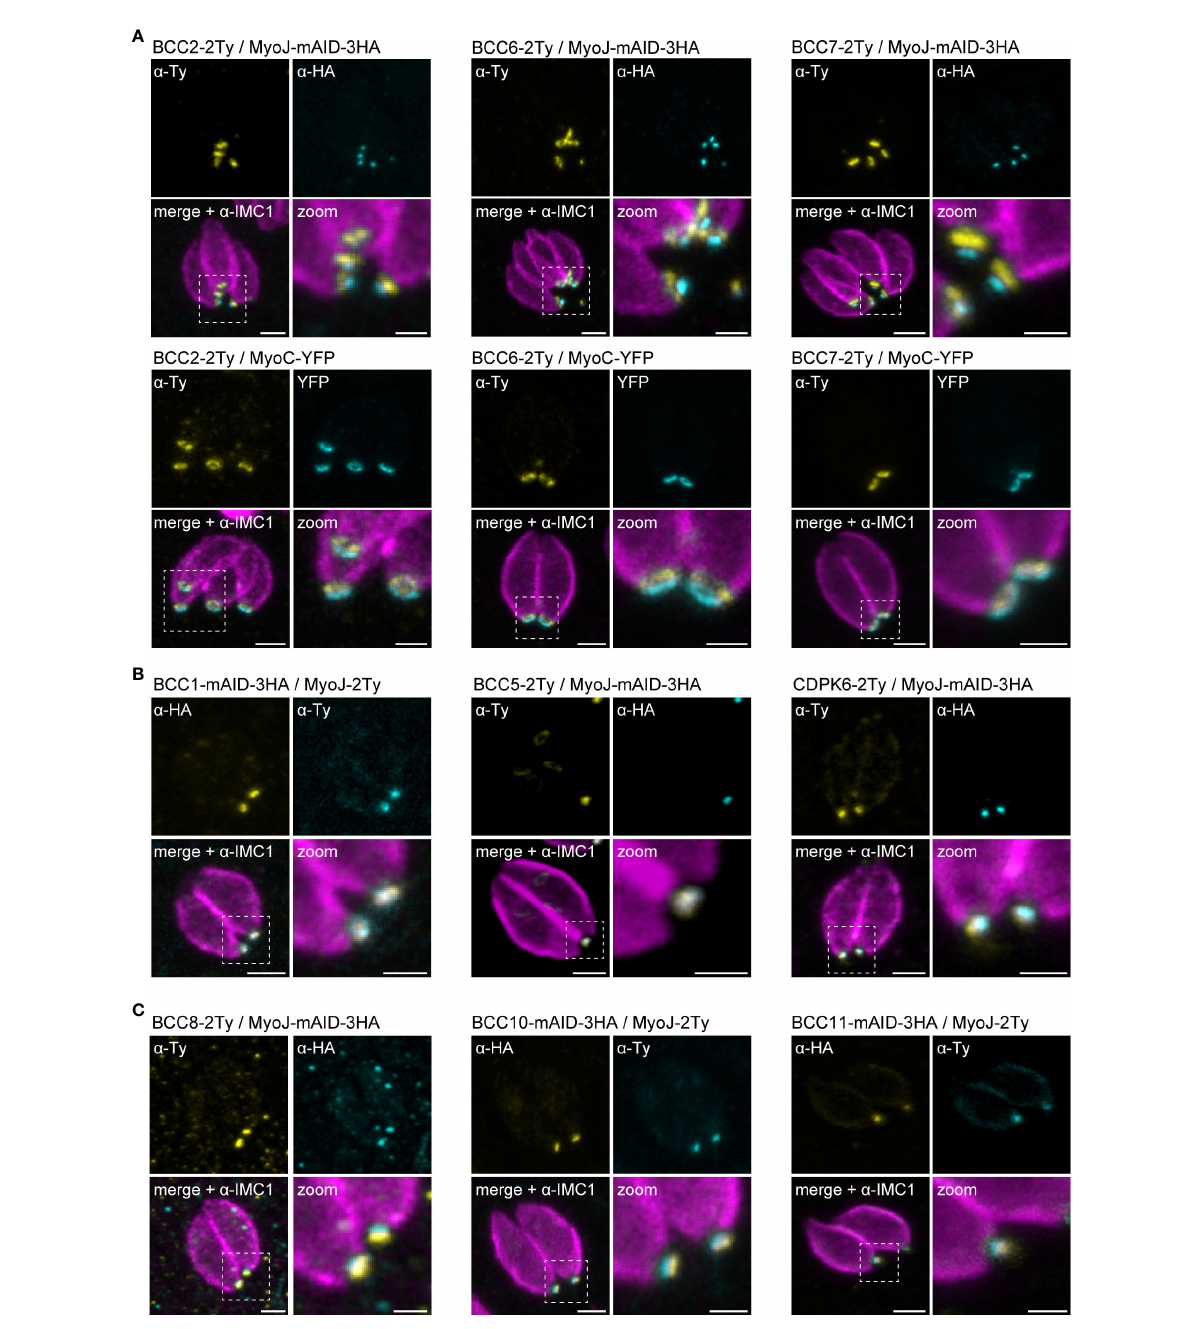
FIGURE 4 Mapping of the BCCs in three sub-compartments of the basal complex, including two new ones. (A) Co-localization of BCC2, BCC6, and BCC7 with endogenously tagged MyoJ and MyoC showing that these three proteins delineate a new sub-compartment located between the basal end of the IMC and the basal ring. (B) BCC1, BCC5, and CDPK6 co-localize with endogenously tagged MyoJ at the posterior cup. (C) A comparison of BCC8, BCC10, and BCC11 staining with endogenously tagged MyoJ shows that these three proteins are located below the posterior cup. Magenta: IMC1, Yellow: BCC of interest, Cyan: MyoC or MyoJ. Scale bars: vacuoles, 2 m m; zooms, 1 m